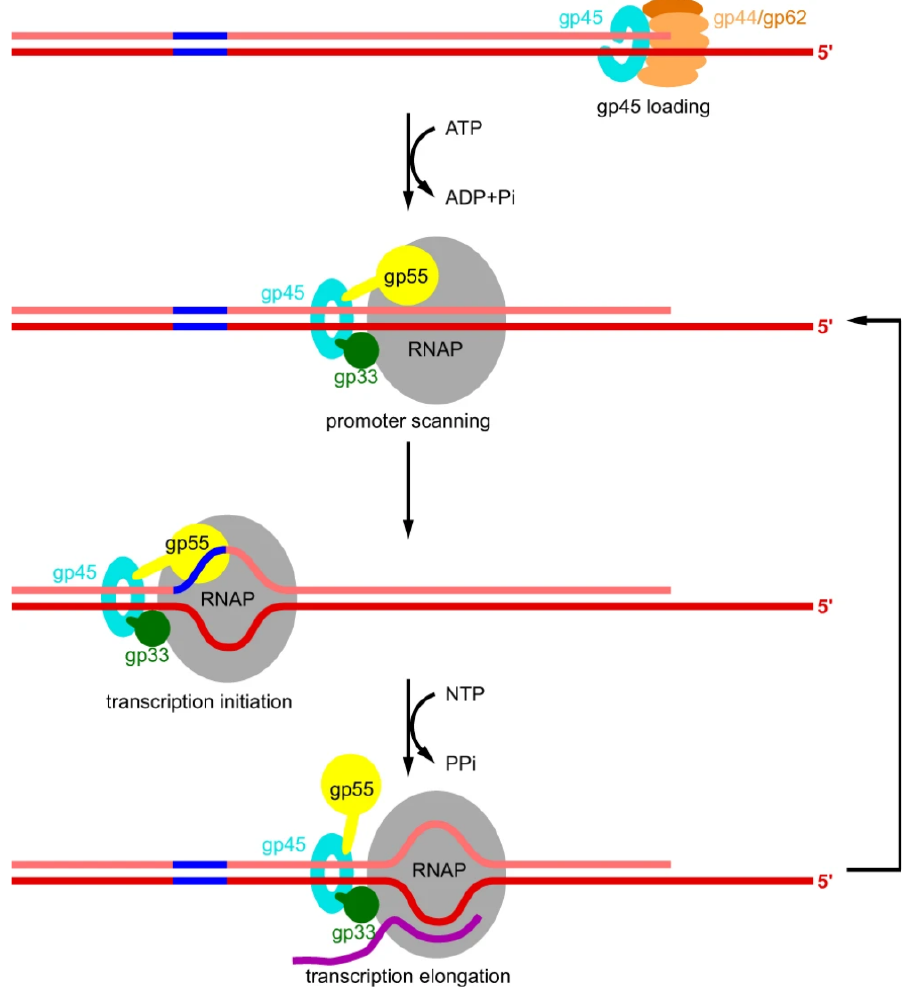
Figure 4. gp45 mediated transcription activation. After the gp45 is loaded onto the DNA, gp55 and gp33 mediate the binding of gp45 with the RNAP. The three proteins, along with the RNAP, start the promoter scanning process along the DNA, and initiate transcription upon interaction with a promoter. Gray, RNAP; light orange, gp44; dark orange, gp62; cyan, gp45; yellow, gp55; dark green, gp33; salmon, nontemplate-strand DNA; red, template-strand DNA; blue, -10-like element; magenta, RNA. Reprinted from ref [65] under the terms of the Creative Commons CC BY license (full terms at http://creativecommons.org/licenses/by/4.0/ (accessed on 3 November 2022)).